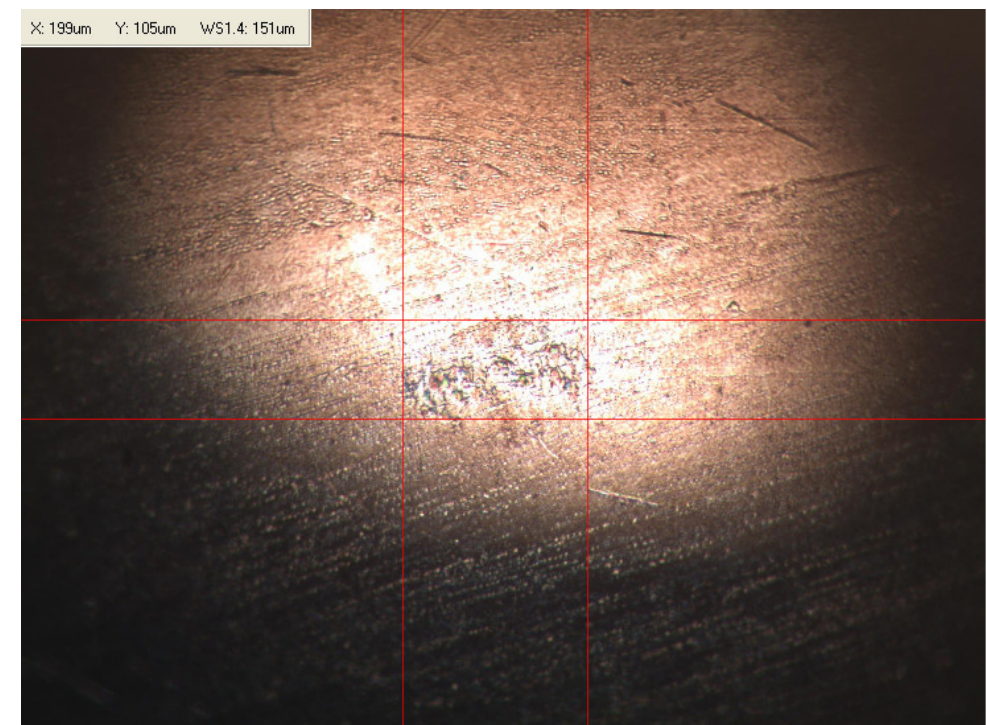
Figure A8. SAE 40—100%; DO—0%.